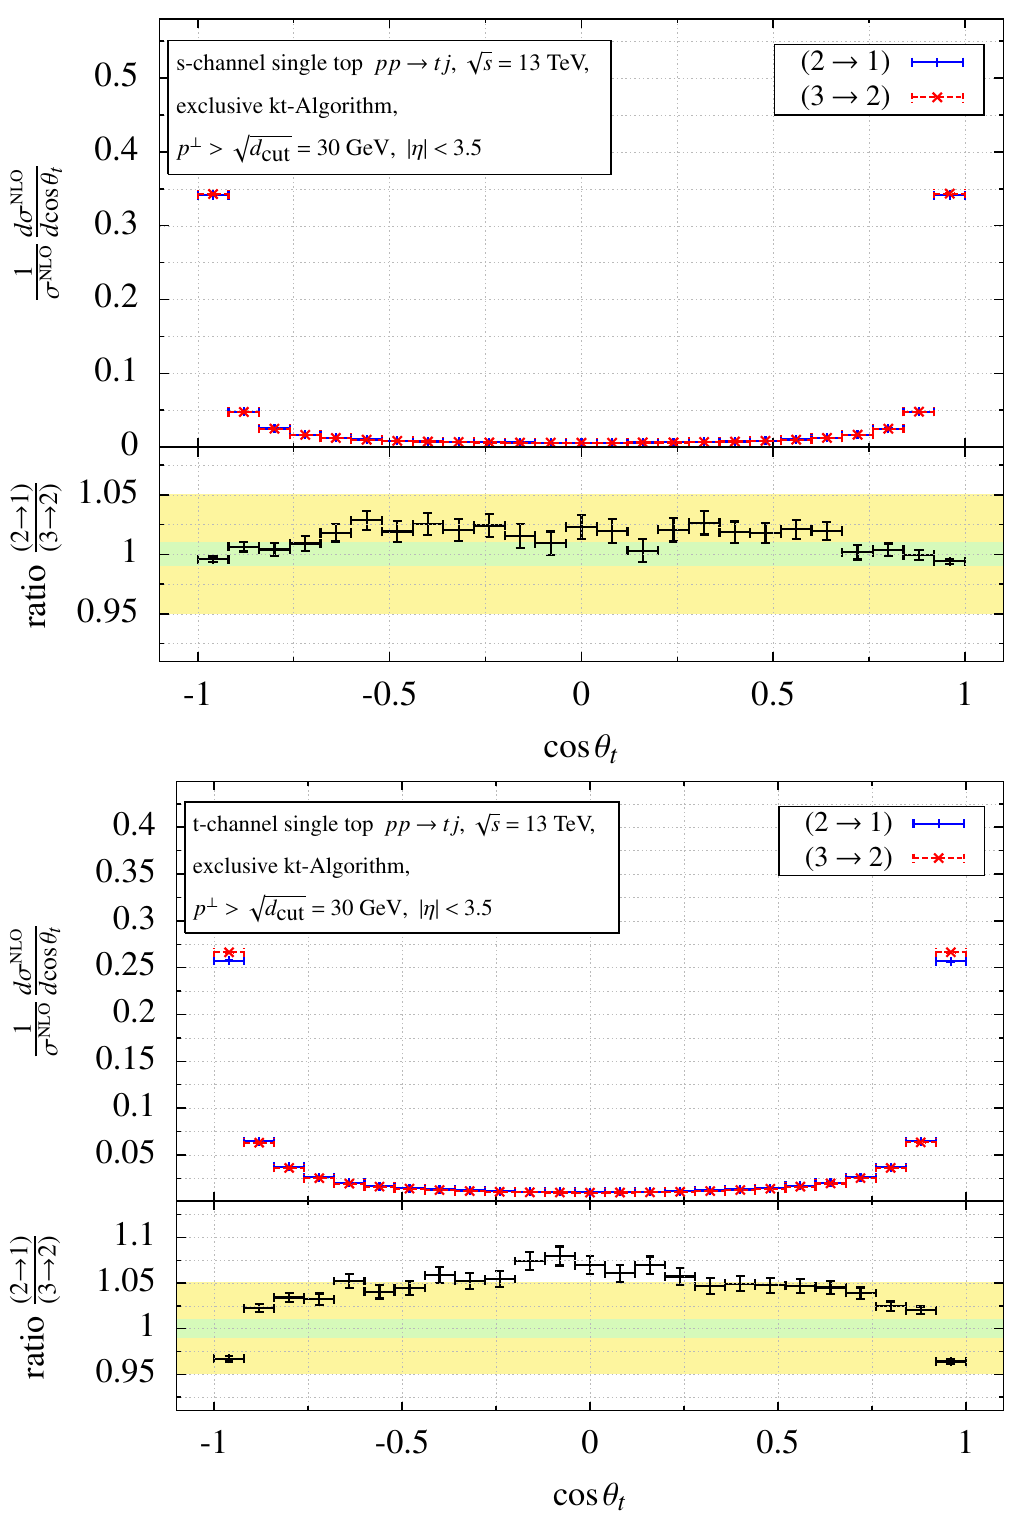
Figure 25 . Polar angle distributions for the top-tagged jet from s - and t -channel single top-quark production at NLO with 3 ! 2 (red, dashed) and 2 ! 1 (blue, solid) jet clusterings.